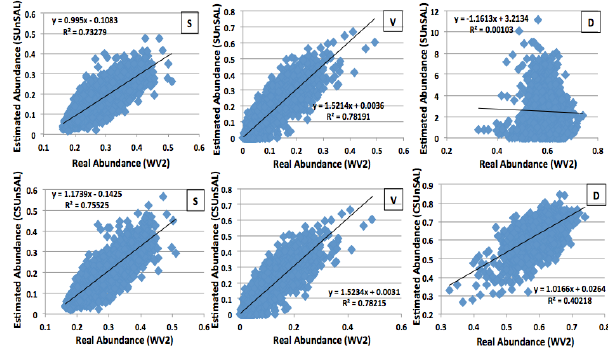
Figure 8. FCC of validation site near Golden Gate Bridge, SF at Landsat and WV-2 spatial resolution.